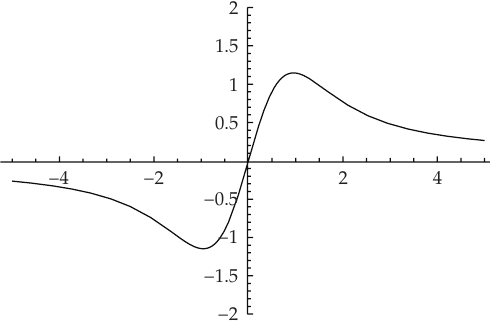
Figure 2: Graph of the conjugate soliton v 0 (cid:3) X (cid:4)